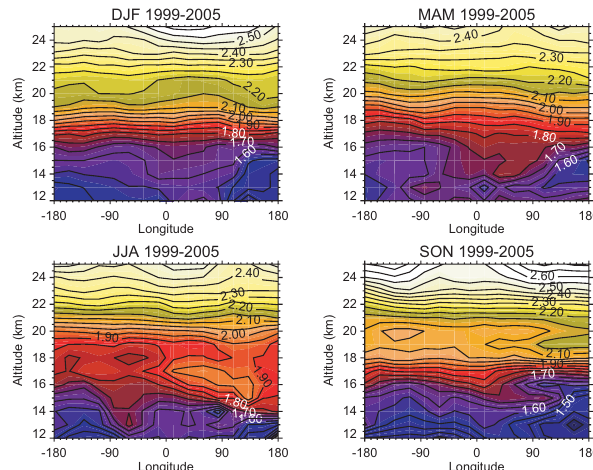
Fig. 8. Seasonal depiction of 1020nm aerosol extinction coefficient ratio (relative to molecular) for 1999–2005 at 16km. Contour levels are drawn at 0.1 increments from 1.5 to 2.2.